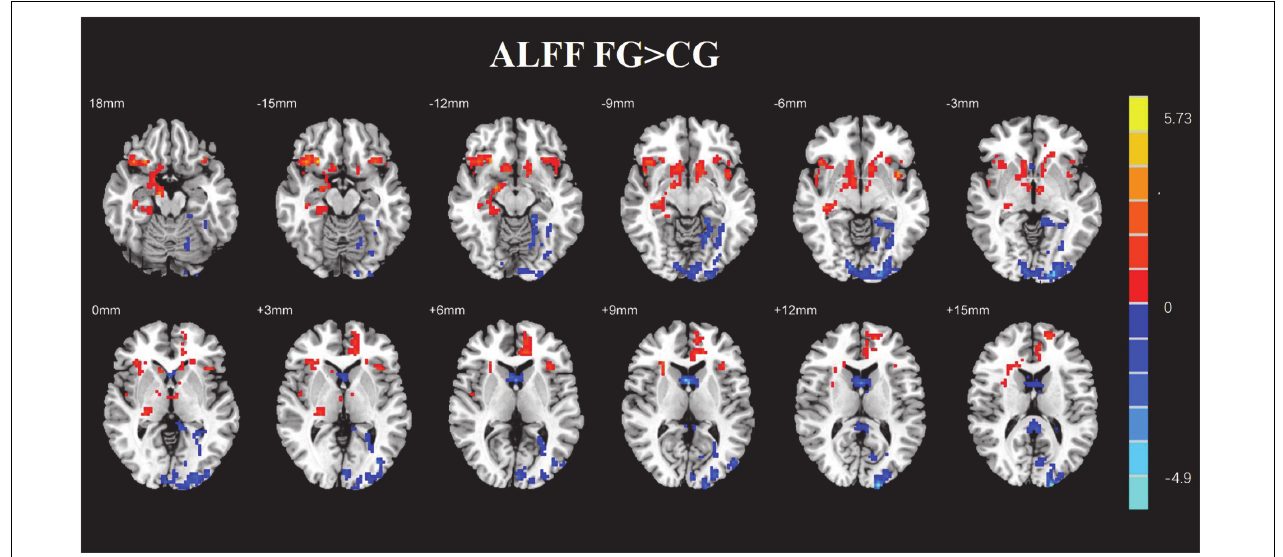
FIGURE 10 | Regions with altered ALFF score comparison of the experimental and CGs. The FG remarkably exhibited reduced ALFF in the left middle occipital gyrus, left parahippocampal gyrus, and right middle frontal gyrus compared with CG. The regions of remarkably increased ALFF were observed in the left anterior cingulate and left superior frontal gyrus (AlphaSim corrected p <